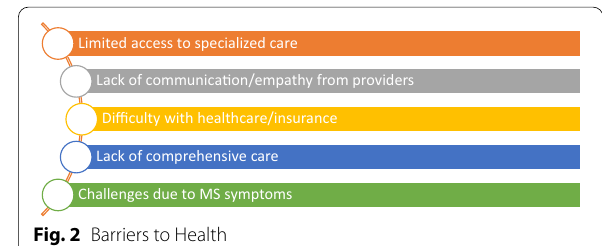
Limited access to specialized